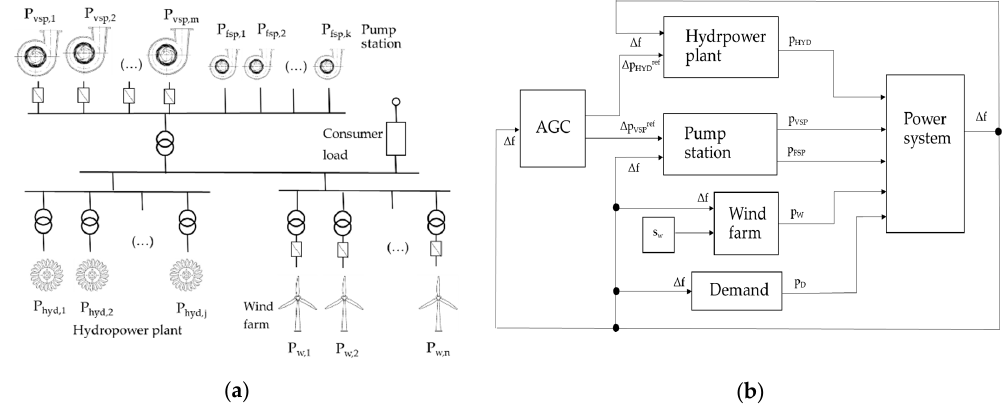
Figure 1. ( a ) Power system simplified one-line diagram and ( b ) dynamic model block diagram.